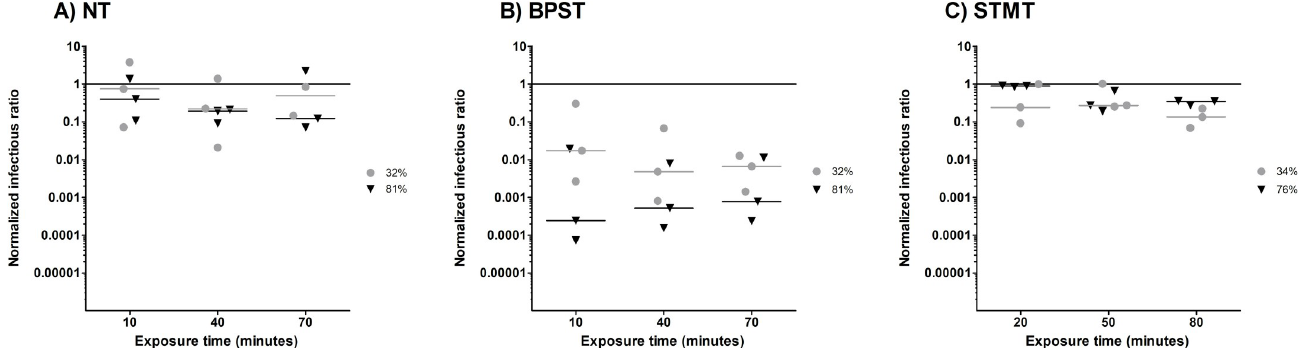
Fig 2. Normalized Infectious Ratios (NIRs) for influenza A at three exposure times and two Relative Humidity (RH) levels. Grey circles ( ● ) represent low RH values (32% or 34%) and black triangles ( ▼ ) represent high RH values (76% or 81%). A) Without supplement (NT), B) with 10% bovine pulmonary surfactant (BPST) and C) with 10% synthetic tracheal mucus (STMT). The nebulizer content is represented by the solid